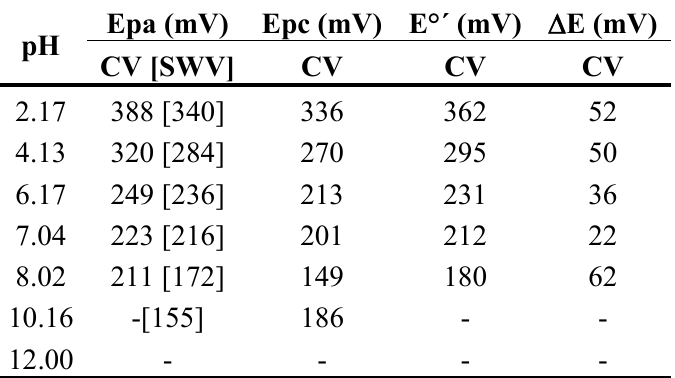
Table1 . Potential parameters obtained from the response of GCE/PPI to pH in 0.1 M phosphate buffer solution (Figure 4b) using both CV and SWV at 100